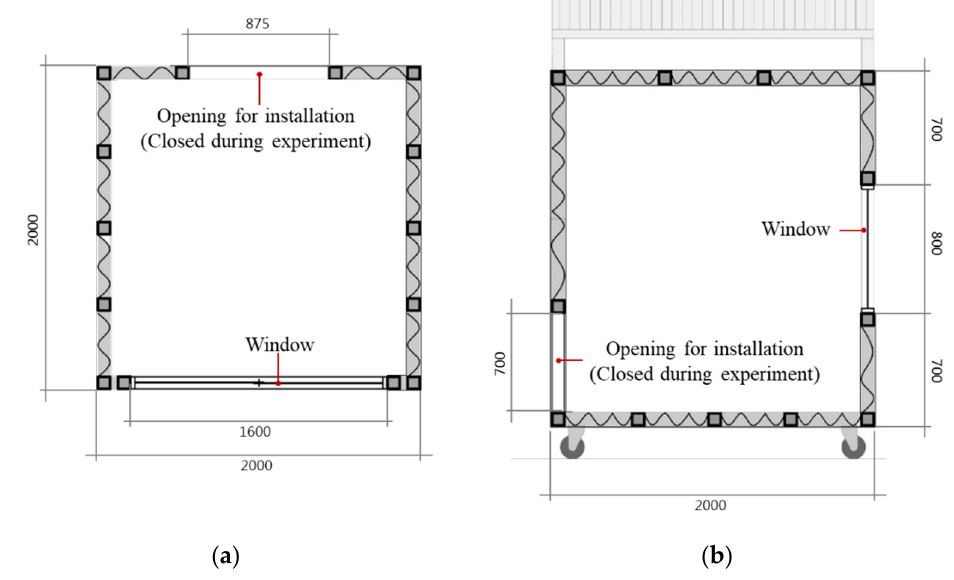
Figure 3. Size of experimental house (unit: mm). ( a ) Plan; ( b ) Section.